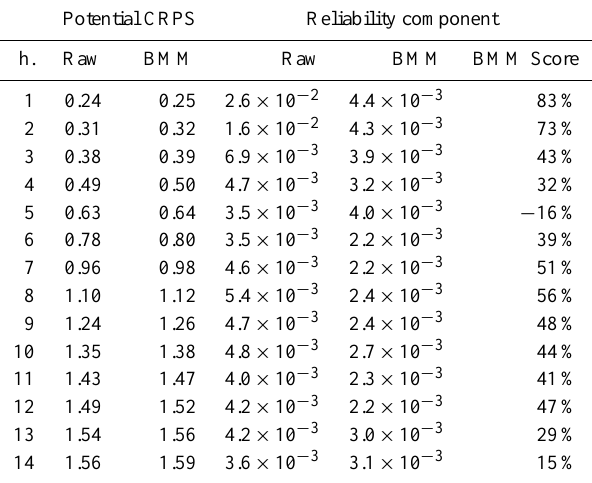
Table 1. The continuous ranked probability score (CRPS) and its decomposition, for raw ensemble prediction system (column “Raw”) and usual best member method (column “BMM”), for all horizons (column “h.”). “BMM Score” is computed assuming that a perfect forecast has reliability component equal to 0. Temperature unit is degrees